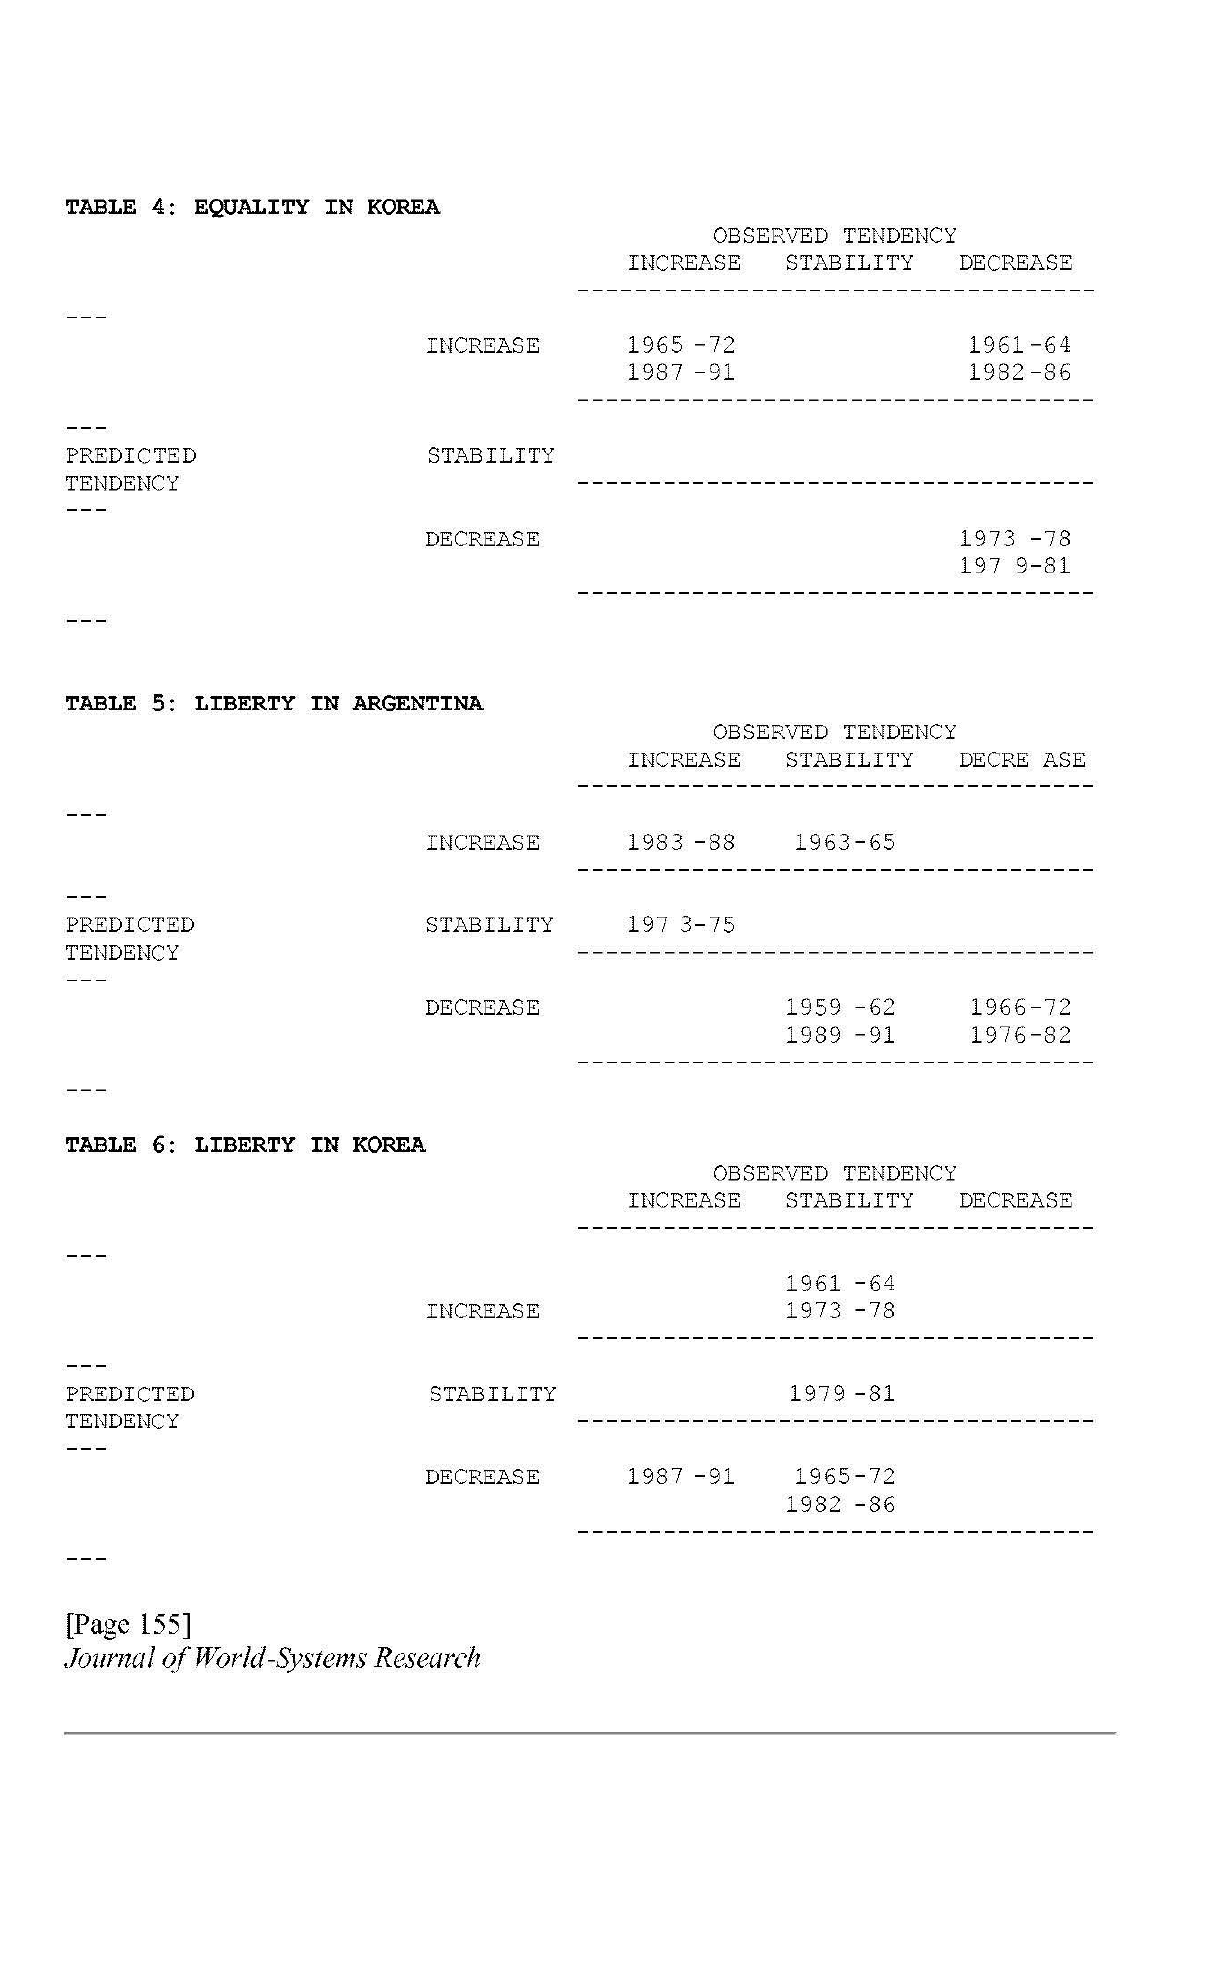
TABLE 4: EQUALITY IN KOREA